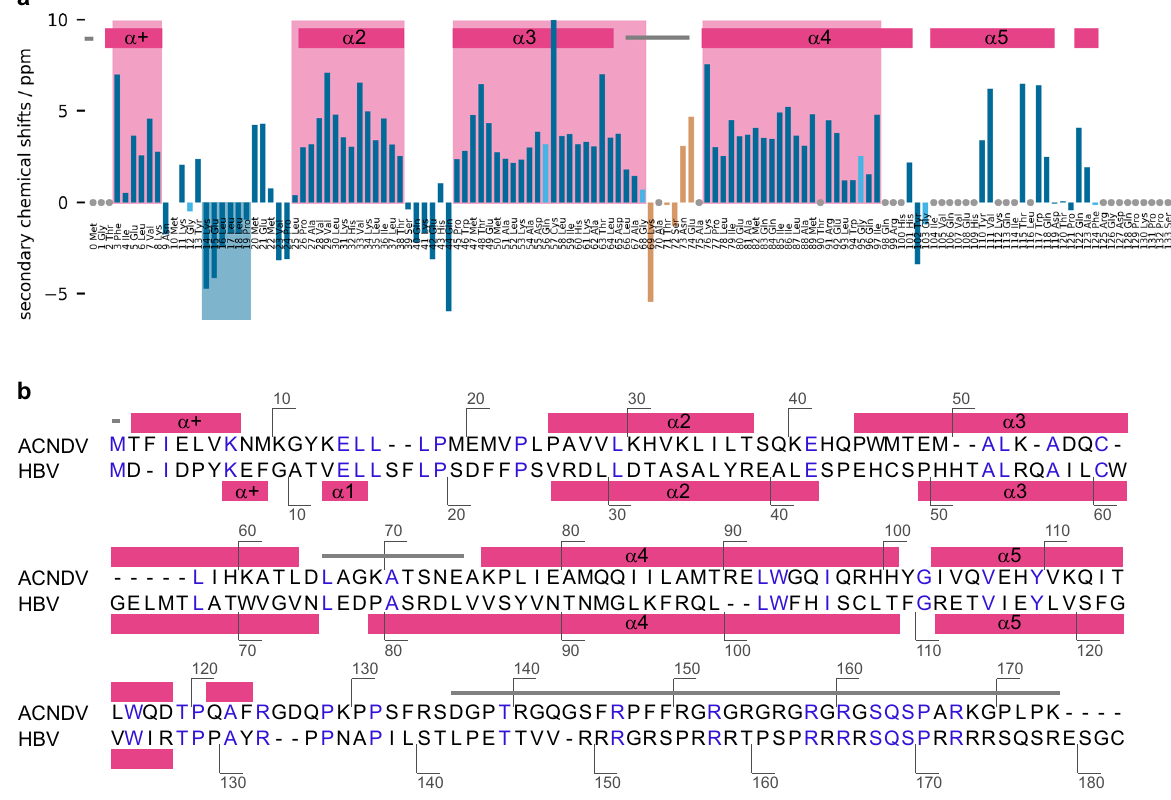
Fig. 1 | ACNDV Cp secondary structure determined by solid-state NMR and alignmentoftheACNDVCp sequencewithHBV Cp.a Secondarychemicalshifts of ACNDV Cp at pH 7.5 calculated from assigned CA and CB resonances. Pink background highlights where ≥ 4positive secondarychemicalsshifts appearinrow ( α -helix)andbluebackgroundwhere ≥ 3negativesecondarychemicalshiftsappear in a row ( β -strand). Light blue vertical lines stand for secondarychemical shifts for which only the CA chemical shift was considered either because the residue is a glycine or because the CB chemical shift could not be assigned. Orange lines indicate tentative assignments (Fig. 4) and gray circles represent unassigned resi- dues. Dark pink horizontal bars show α -helices from the cryo-EM structure of ACNDV chain A and gray horizontal lines indicate regions where the map density was not resolved. b The alignment of ACNDV Cp with HBV Cp was taken and adapted from Lauber et al. 1 . Annotations for secondary structure elements of